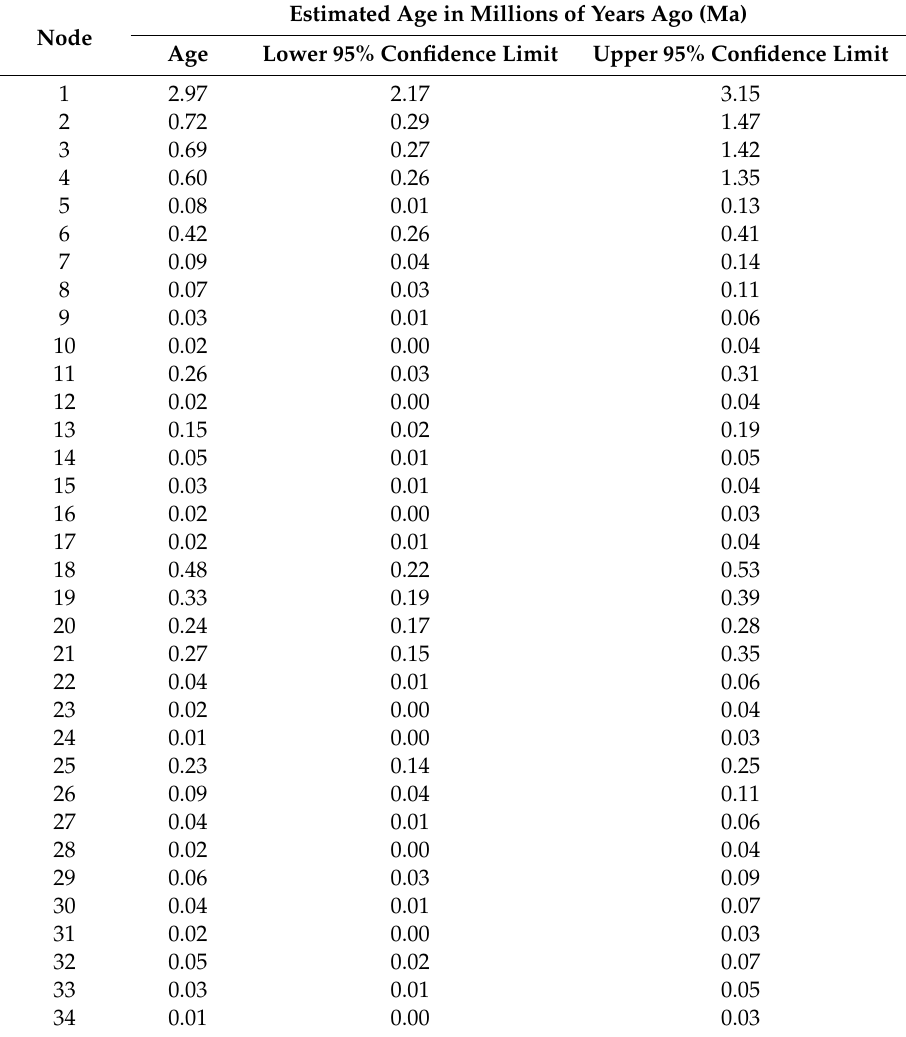
Table 4. Divergence times of A. triastriatus , estimated by the Bayesian method.